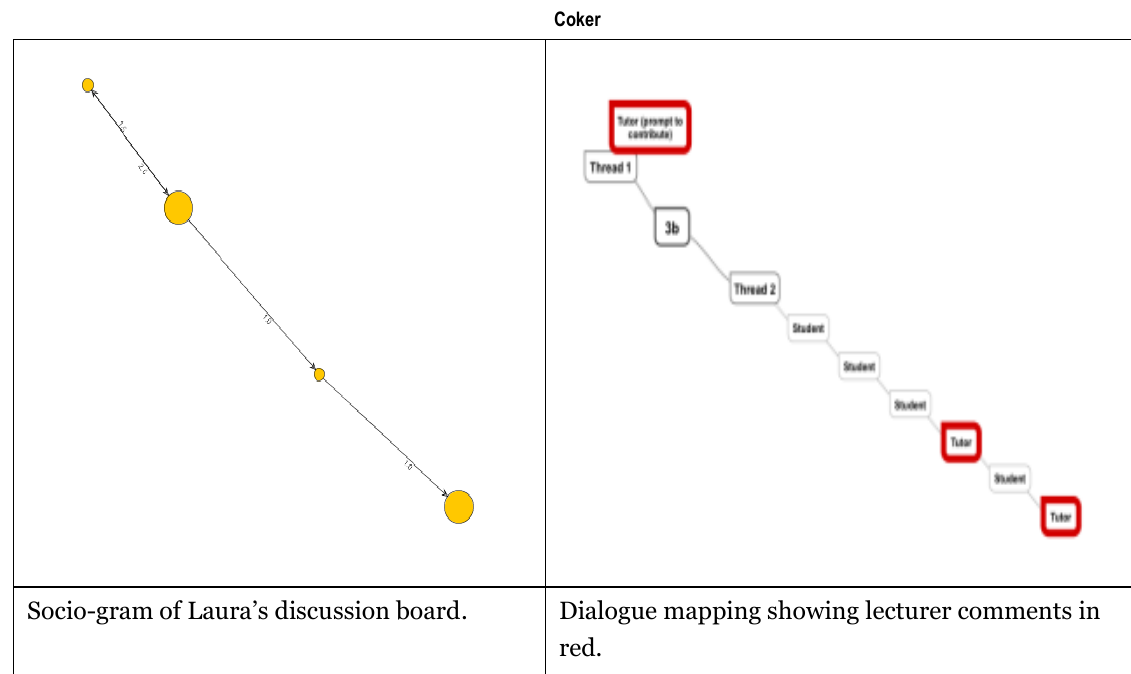
Dialogue mapping showing lecturer comments in red. Figure 4. Visualisations of a discussion board: Laura. Sociograms from all of Laura’s modules displayed single lines of dialogue (Figure 4). Laura took a directive approach and positioned herself within the discussion, acting to stimulate and generate student’s continued